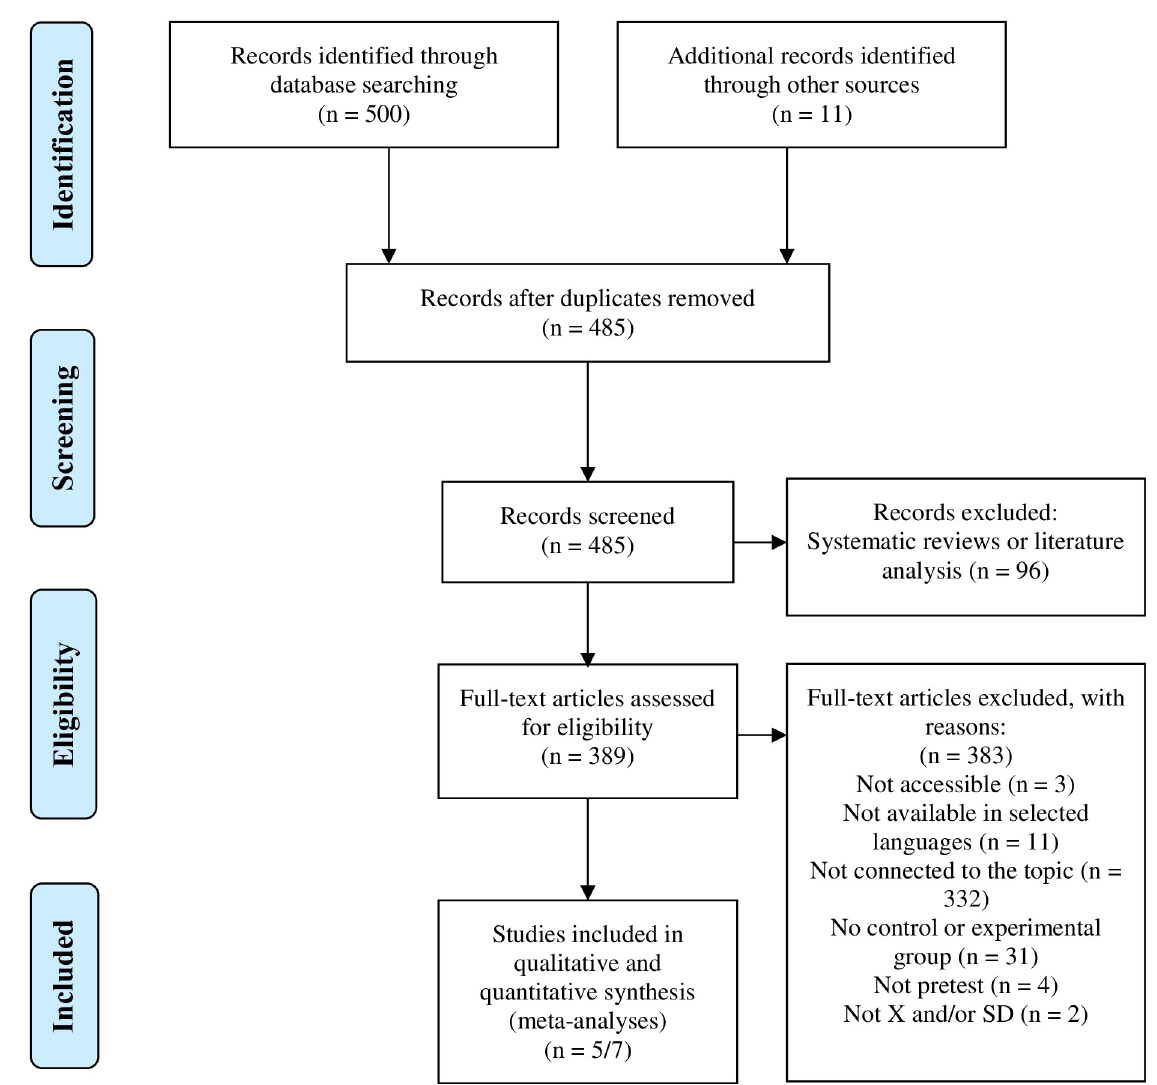
Fig 1. Flow diagram for the systematic review process according to PRISMA